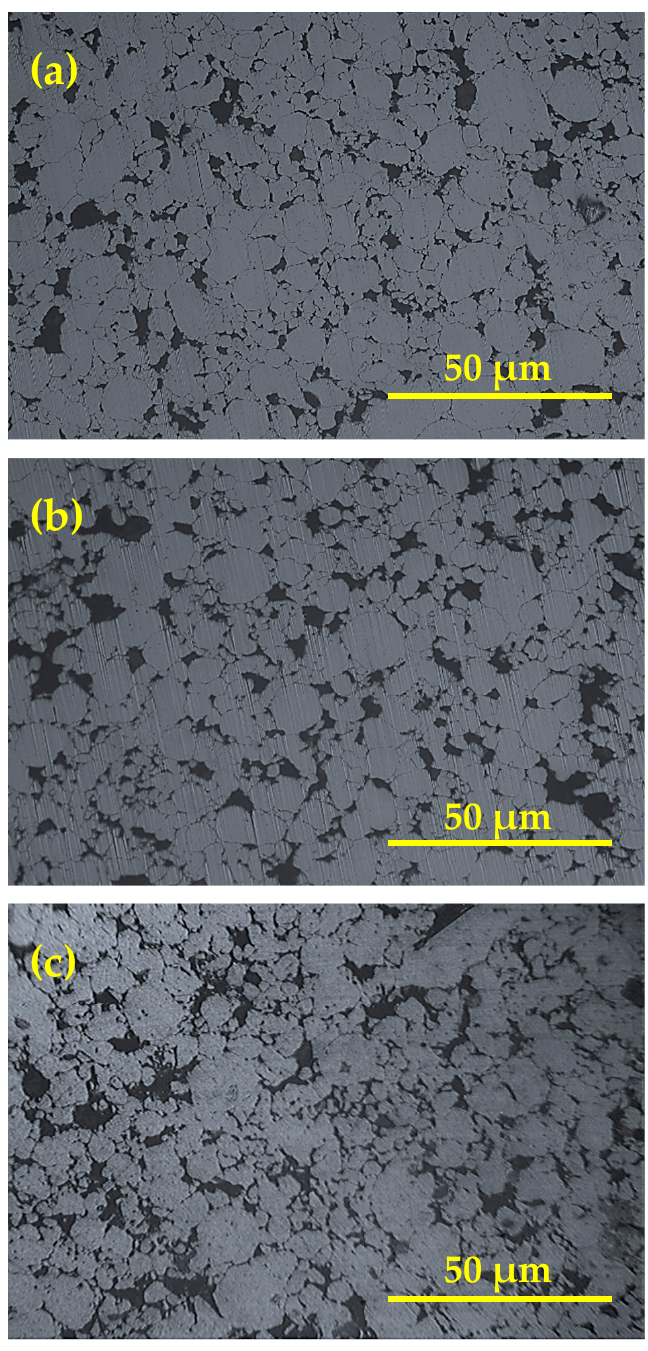
Figure 4. Microstructure of Cu-Al 2 O 3 nanocomposites; ( a ) Cu-2.5%Al 2 O 3 , ( b ) Cu-7.5%Al 2 O 3 , ( c ) Cu-12.5%Al 2 O 3 .